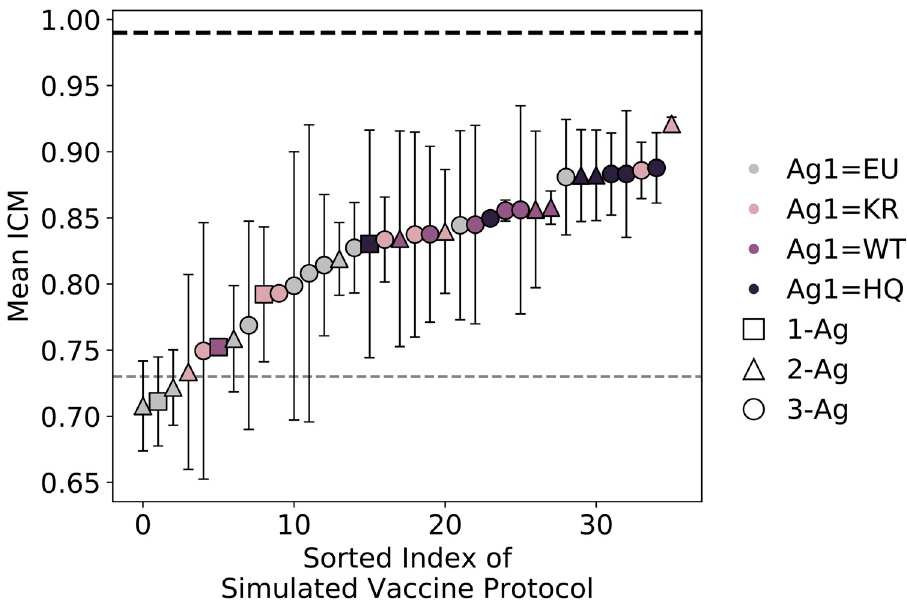
Fig 4. Results from AM simulations: mean weighted degree of interfacial composition and electrostatic pattern matching (ICM) of all 1-, 2-, or 3-Ag protocols, sorted by the mean ICM score. Error bars represent the standard deviation of two independent simulations of each vaccination protocol (except for the KR-KR-KR and HQ-EU-WT protocols, for which only one successful trial could be obtained), consisting of between one and three immunizations/ GC reactions. Gray and black dotted lines indicate the respective values for VRC01GL and VRC01.